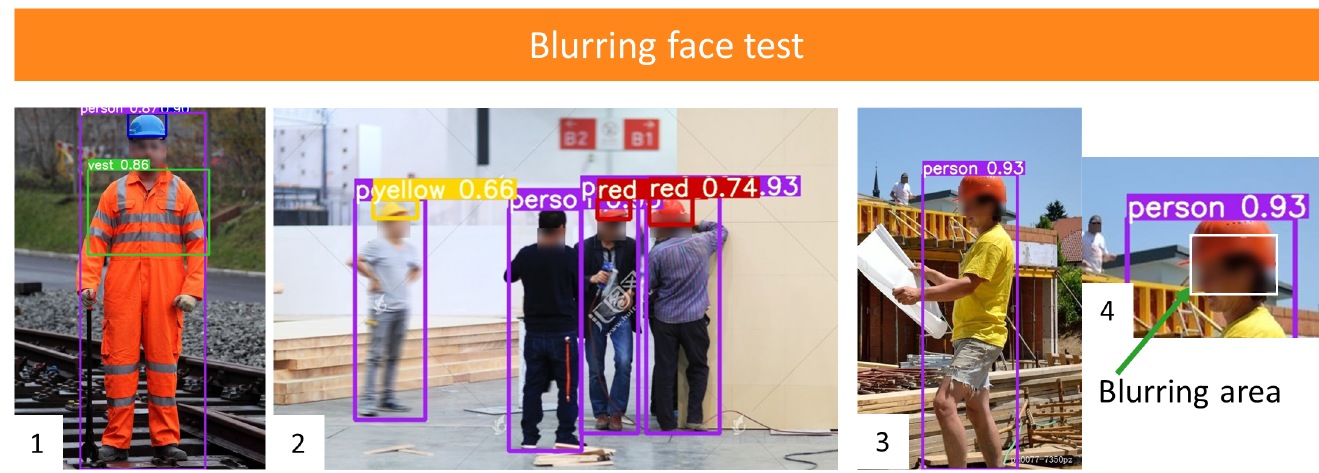
Figure 14. Blurring face test on YOLO v5x.